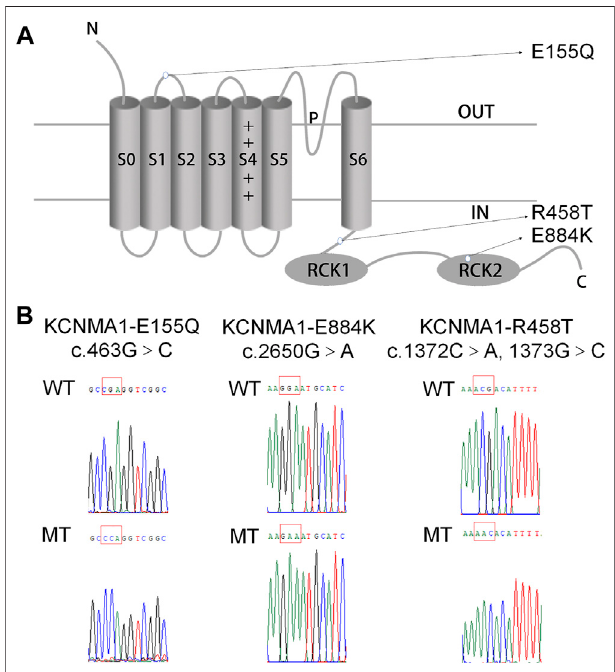
FIGURE 1 | Location and sequencing of the KCNMA1 variants. (A) Predicted transmembrane topology of KCNMA1 depicting the location of the variants. (B) DNA sequencing identi fi ed the mutations in the constructed hBK α plasmid. The mutation sites are marked by a red